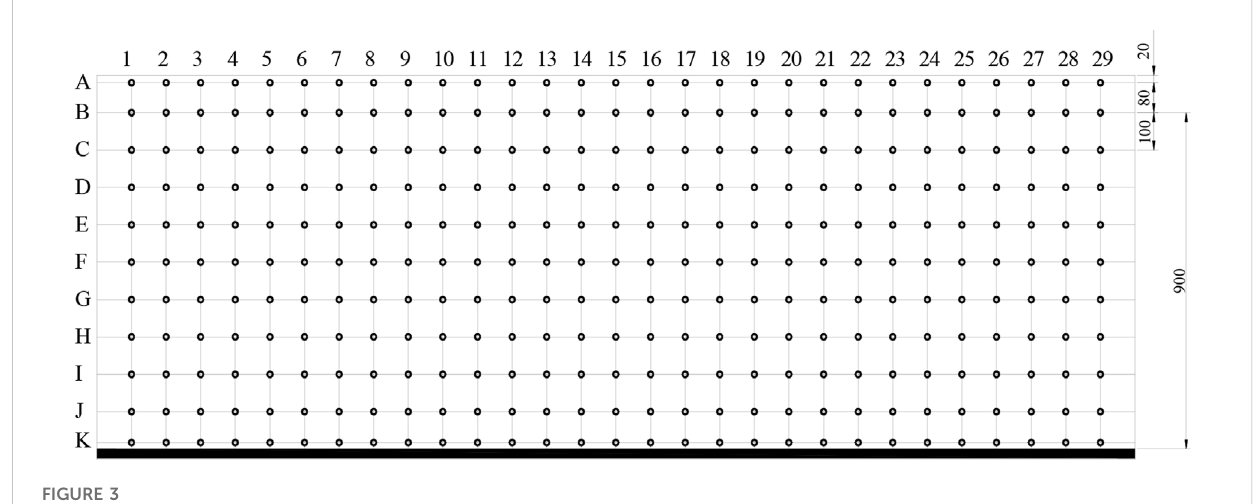
FIGURE 3 Layout of displacement measuring points.